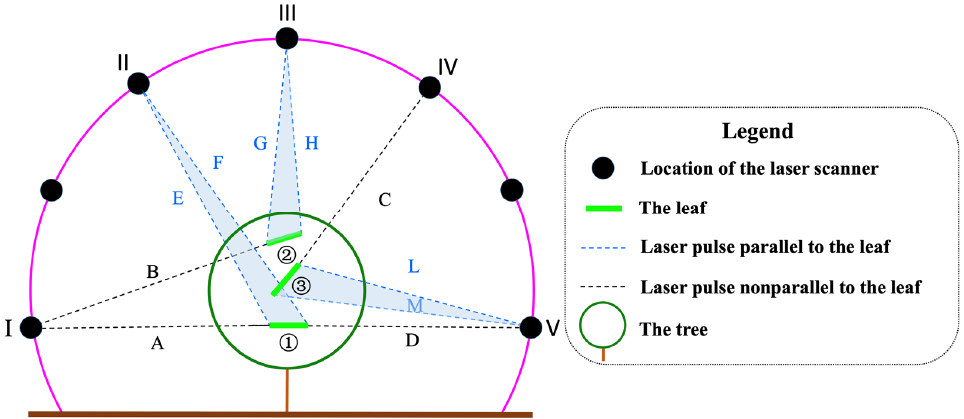
Figure 10. Hemispherical scanning of a tree using UAV laser scanning (UAVLS). Leaf ① is horizontal, and leaf ② and leaf ③ are slanted. Dashed lines represent the pulses emitted by the laser scanner: A, B, C and D are parallel to the leaf, indicating that no point can be acquired in these cases, and the rest (in blue) represent pulses that intersect with the leaves, indicating that some points can be acquired through scanning.